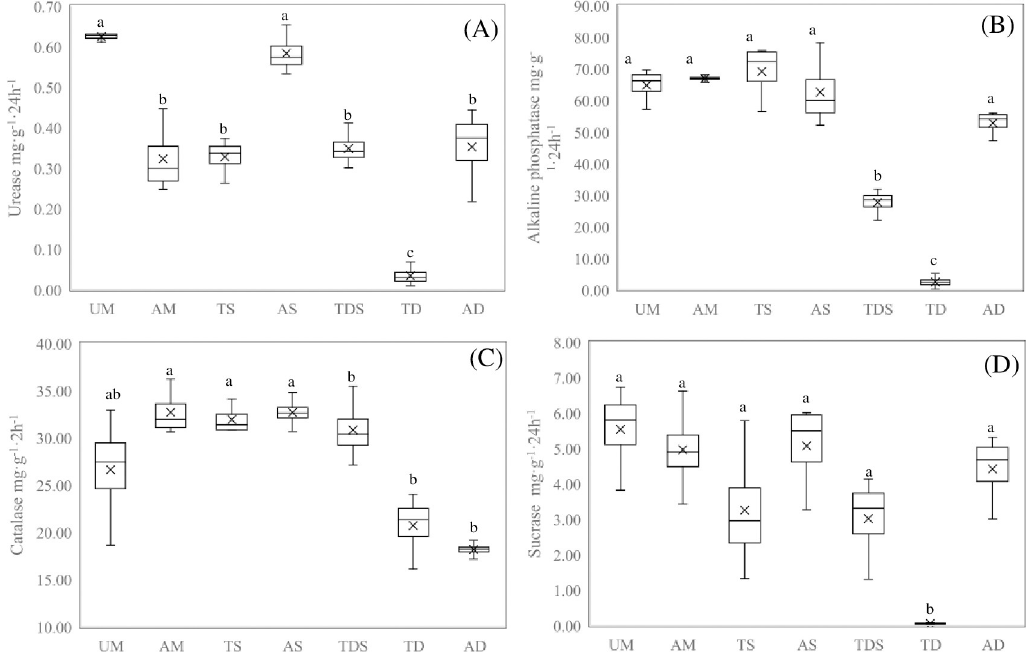
Fig 3. Soil enzyme activity in different types